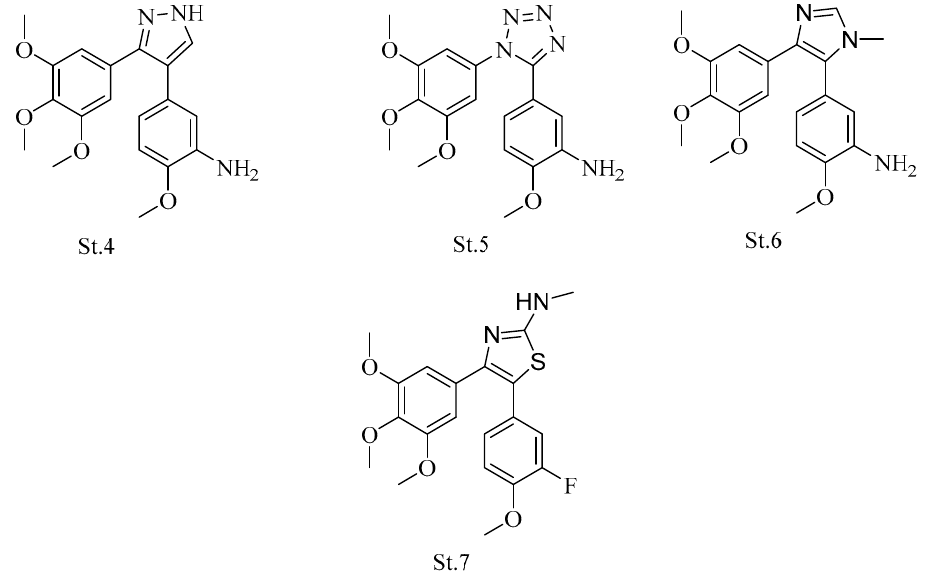
Figure 3. The structures of CA-4 analogues when the linker is replaced with heterocycles (pyrazole, tetrazole, and thiazole).